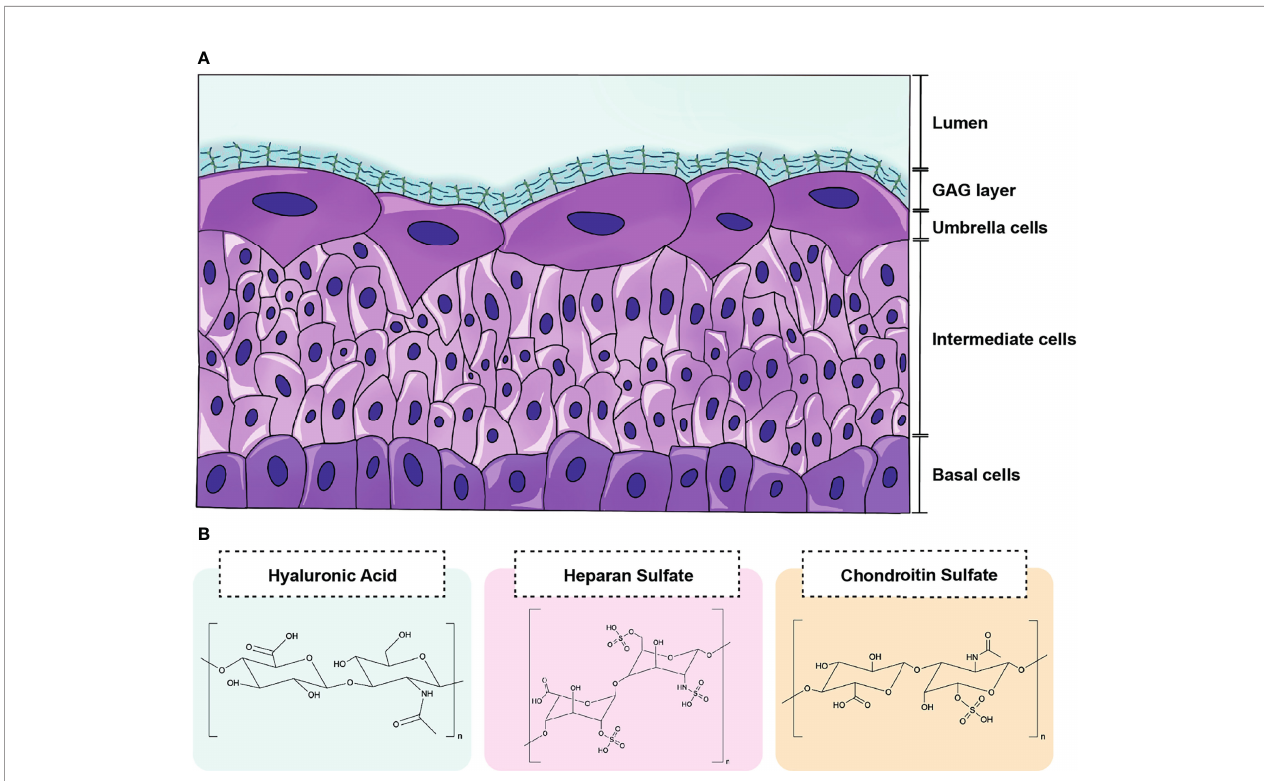
FIGURE 1 | Schematic of GAG layer and major urinary GAG structures. (A) The luminal surface the bladder epithelium is coated by a GAG layer that lines terminally differentiated super fi cial cells termed umbrella cells. (B) The GAGs most relevant to the urinary tract include hyaluronic acid (HA), heparin/heparan sulfate (HP), and chondroitin sulfate (CS). HA contains repeating disaccharide units of d-glucuronic acid and N-acetylglucosamine bonded by alternating b -1,4 and b -1,3 linkages. HP is comprised of repeating disaccharide units d-glucuronic acid and d-N-acetylglucosamine bonded by b -1,4 linkages. CS consists of N-acetyl-d-galactosamine and b -glucuronic acid connected by alternating b -1,3 and b -1,4